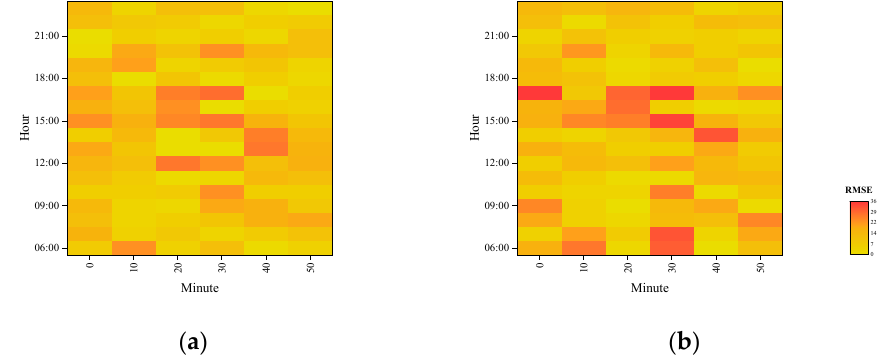
Figure 6. The RMSE errors distribution of inflow at 10-min granularity. ( a ) AMGC-AT; ( b ) STGCN.